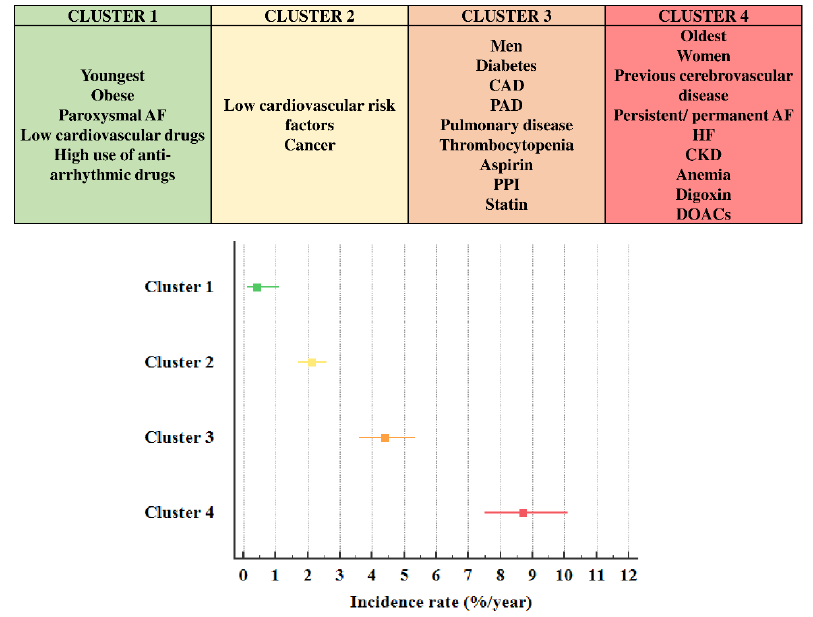
Figure 1. Description of clusters characteristics and incidence rates of mortality. Abbreviations: AF: atrial fibrillation; CAD: coronary artery disease; PAD: peripheral artery disease; PPI: proton pump inhibitors; HF: heart failure; CKD: chronic kidney disease; DOACs: direct oral anticoagu- lants.